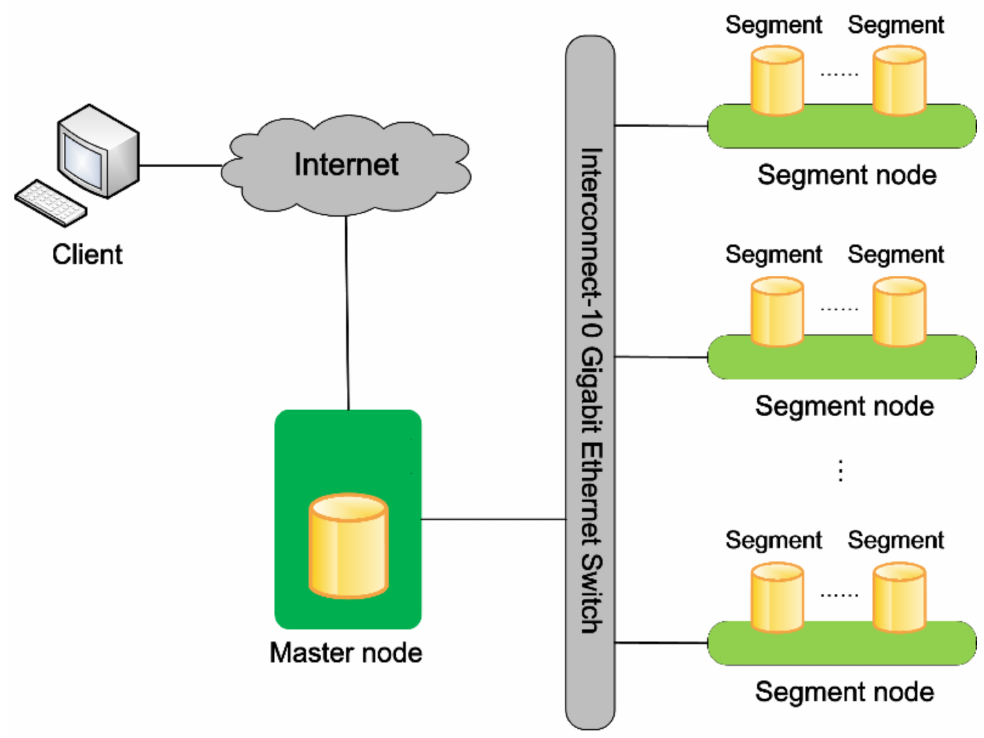
Figure 5. A high-performance computer cluster for the distributed observational